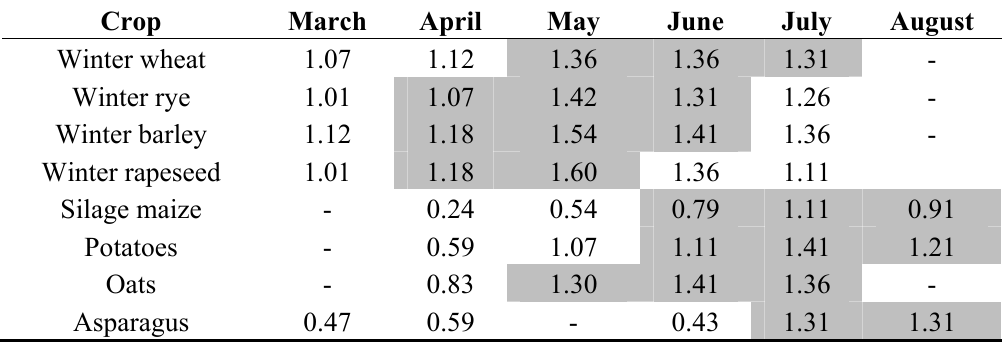
Table 1. Crop coefficients for the months ( K with possible irrigation (dark